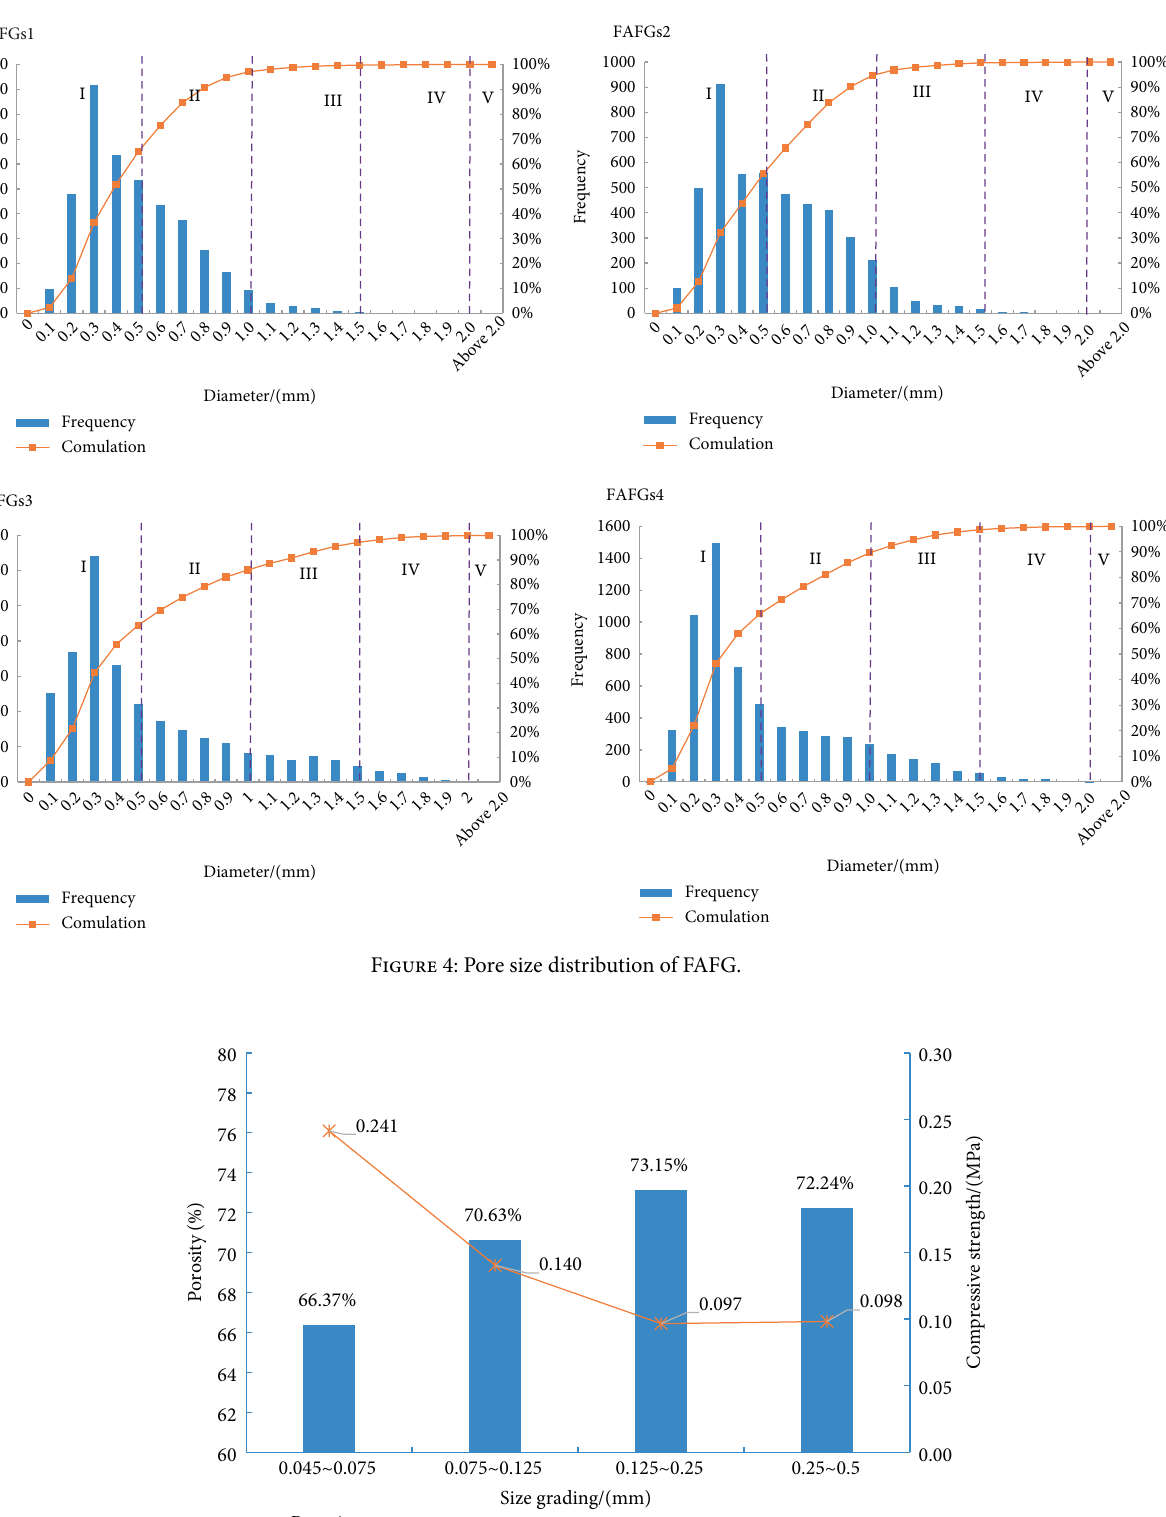
Figure 5: Curve of porosity and compressive strength to size